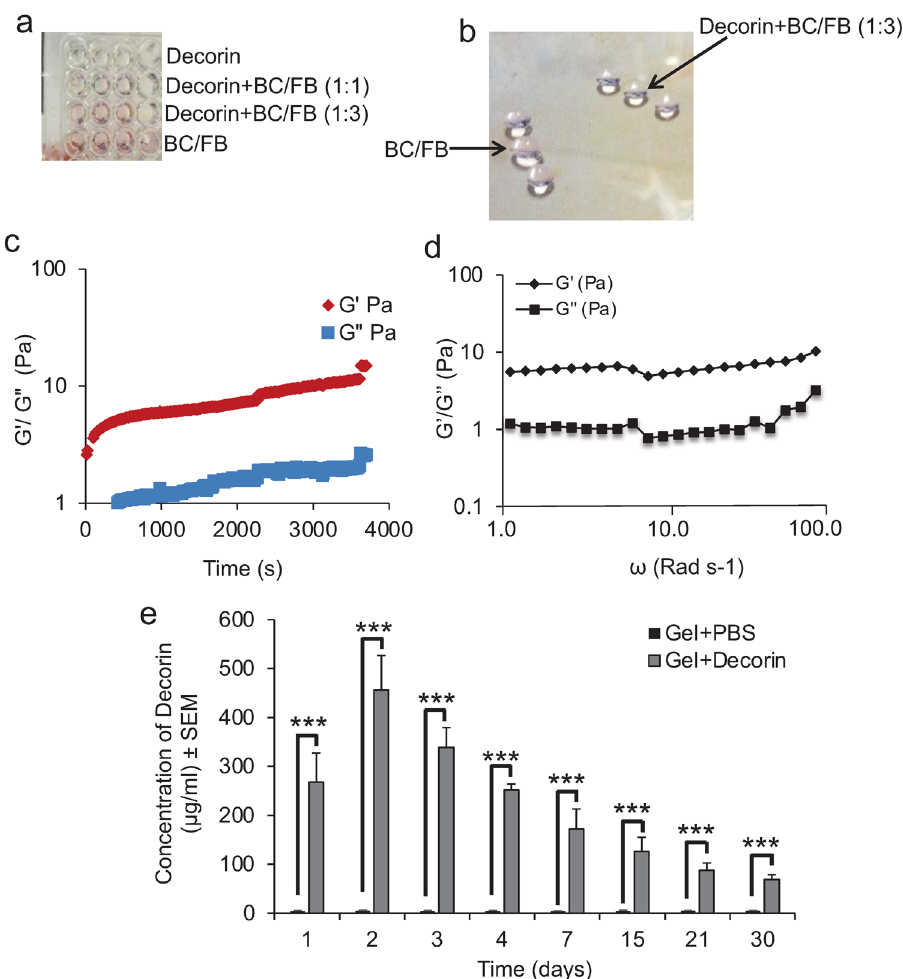
Figure 1. In vitro properties of injectable Gels. ( a ) BC/FB formed Gels when incubated at 37 °C in 96-well plates and could still polymerise into a Gel, enough to be scooped out ( b ) when 25% of its volume was Decorin (in PBS) (i.e. 1:3 Decorin:BC/FB) but not when 50% of its total volume was Decorin (i.e. 1:1 Decorin: BC/ FB). ( c ) Frequency time-sweep measured the stability of the Gel over time. ( d ) The mechanical properties of the Gel were assessed by measuring the storage modulus (G’) and loss modulus (G’’) across a range of angular frequencies, ω. ( e ) Decorin or PBS was preloaded into the BC/FB Gels and was released when placed into 1 ml of PBS at increasing concentrations/day to a maximum at 2 days, declining gradually over the next 30 days. However, significant amounts of Decorin were still being released from the Gel at 15 days. *** P < 0.0001, one- way ANOVA with Dunnett’s post hoc test, Gel + Decorin vs Gel + PBS. n = 4 Gels/group, 3 independent repeats, total n = 12 Gels/group. No Decorin was detected in Gel + PBS-treated